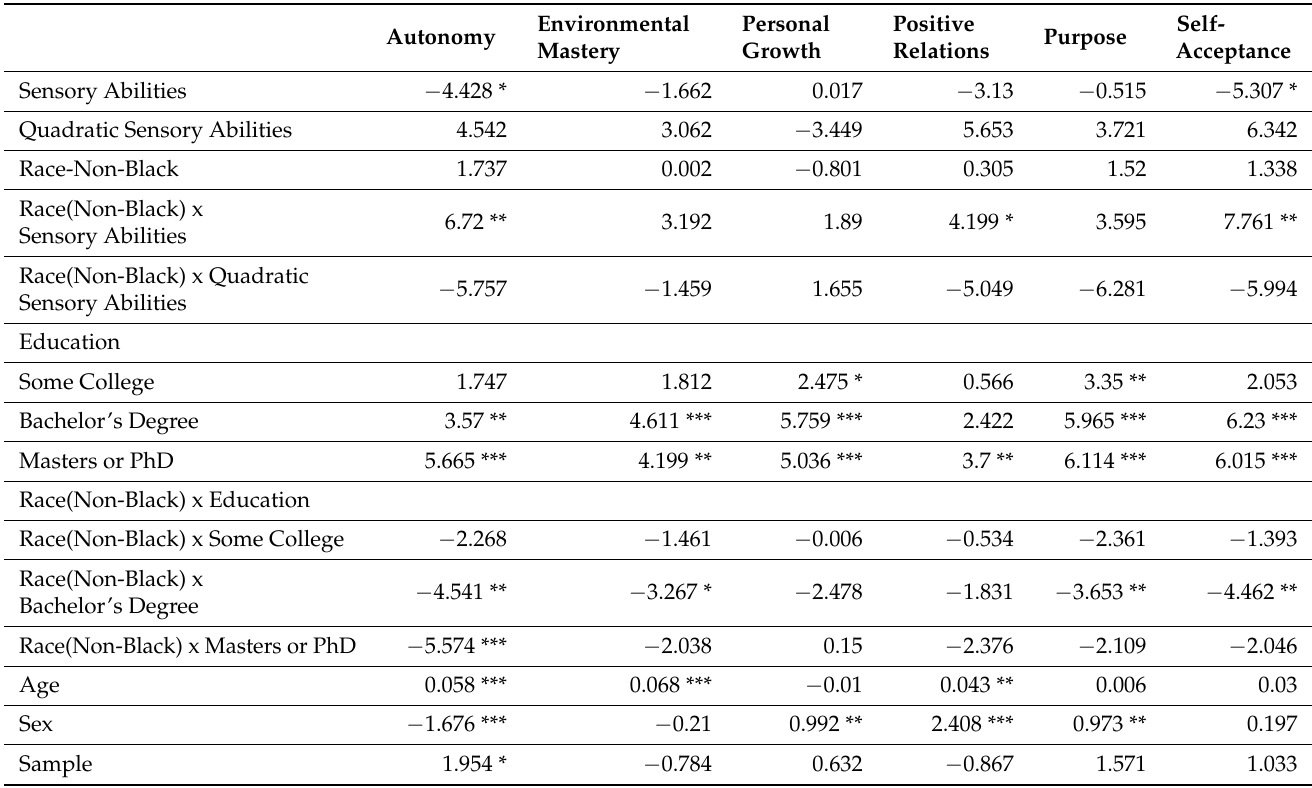
Table A1. Sensory Abilities and